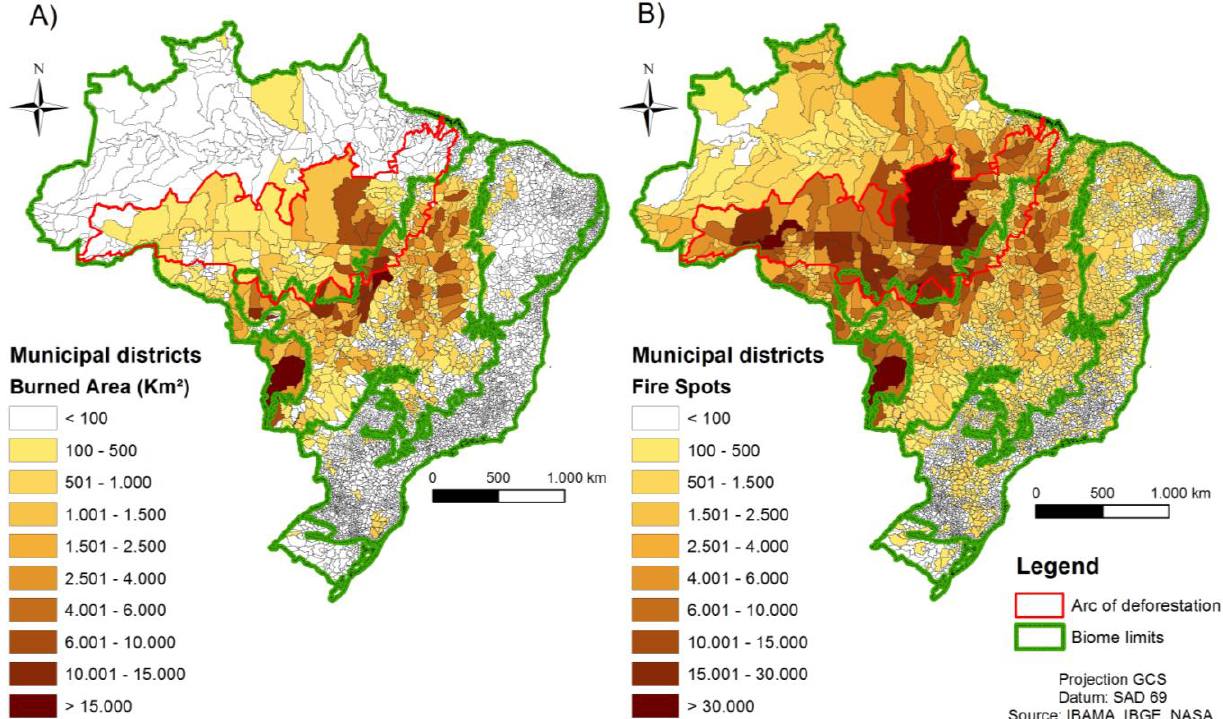
Figure 5. ( A ) Total burned area (MCD45A1); and ( B ) fire hotspots (MOD14 and MYD14), between 2002 and 2010, according to the Brazilian municipalities.